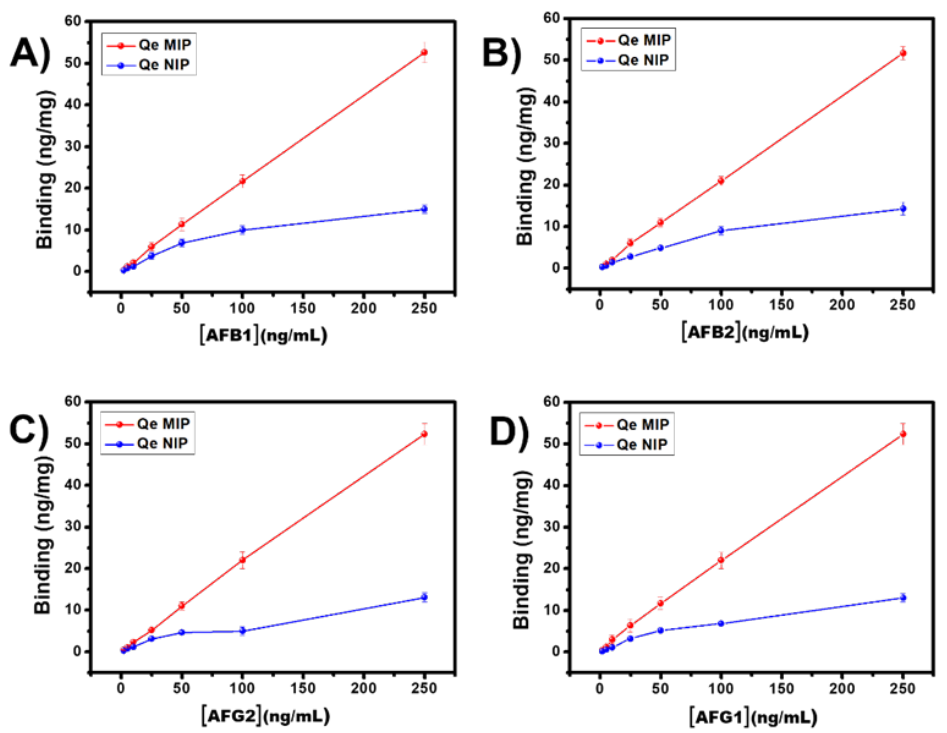
Figure 2. Adsorption capacity (%) of the MIPs (red) and NIPs (blue) obtained analyzing different aflatoxin amounts (from 2 to 250 ng/mL). Graphs ( A – D ) correspond to aflatoxins B1, B2, G1, and G2, respectively.